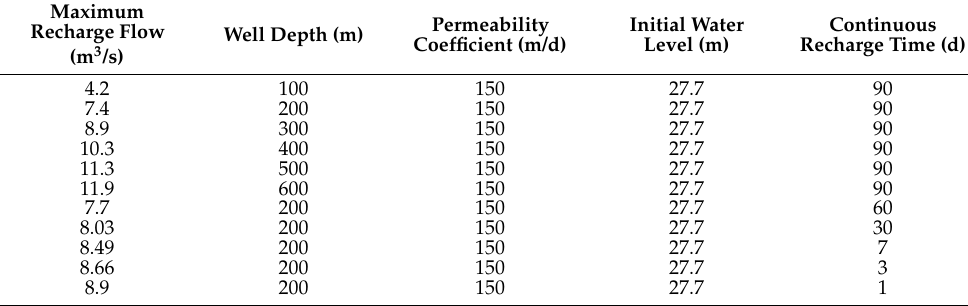
Table A2. Maximum pumping flow of different working